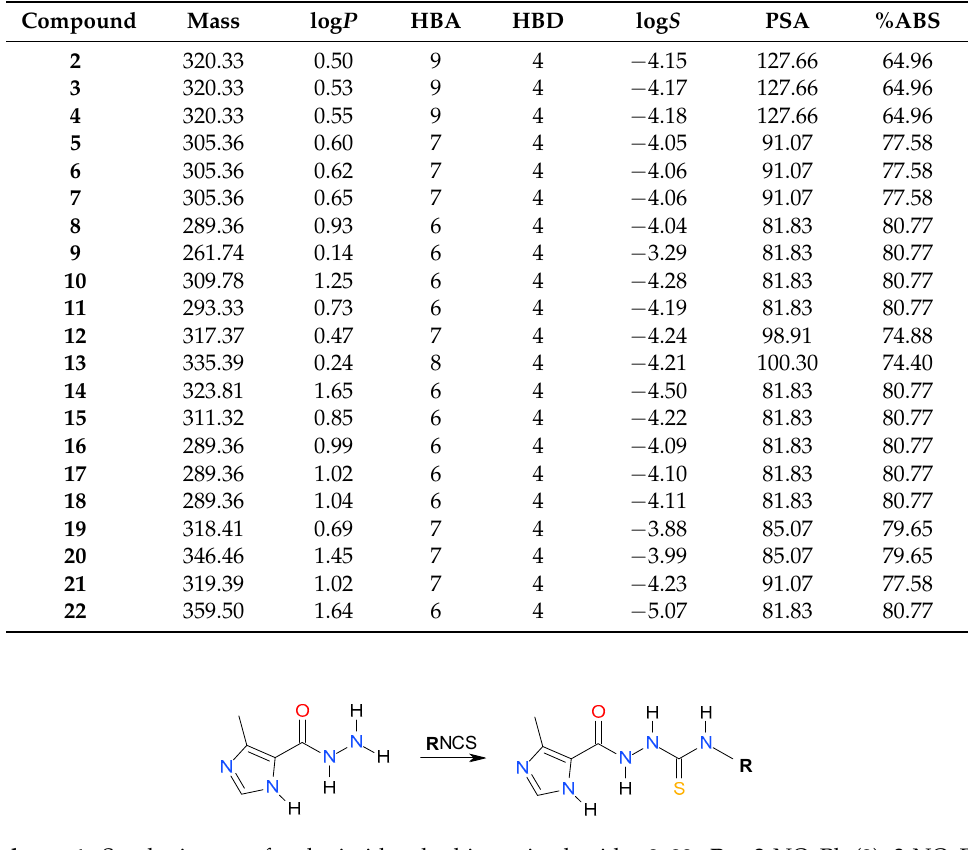
Table 1. Physicochemical properties of 2 – 22 important for CNS penetration. HBA—number